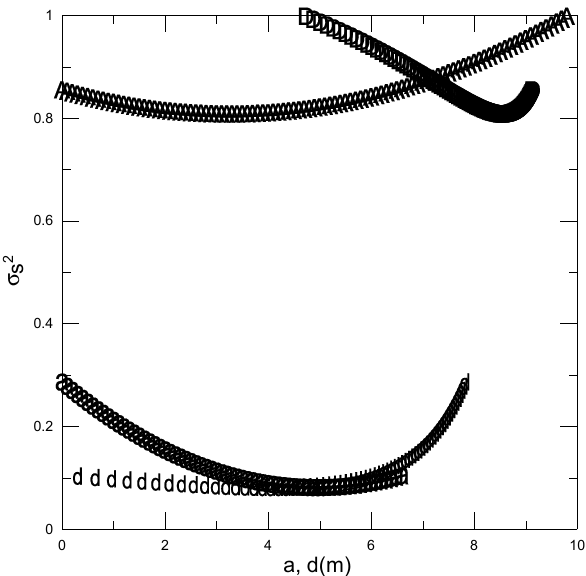
Figure 3. Example of σ S2 (Equation (1)) for Δ U and for ΔΘ v calculated as a function of a (symbols: a for Δ U and A for ΔΘ v ) and of d (symbols: d for Δ U and D for ΔΘ v ), for the couple of Levels 2–3. The abscissa of the minima represents the estimated value of a and d for Δ U and for ΔΘ v in each